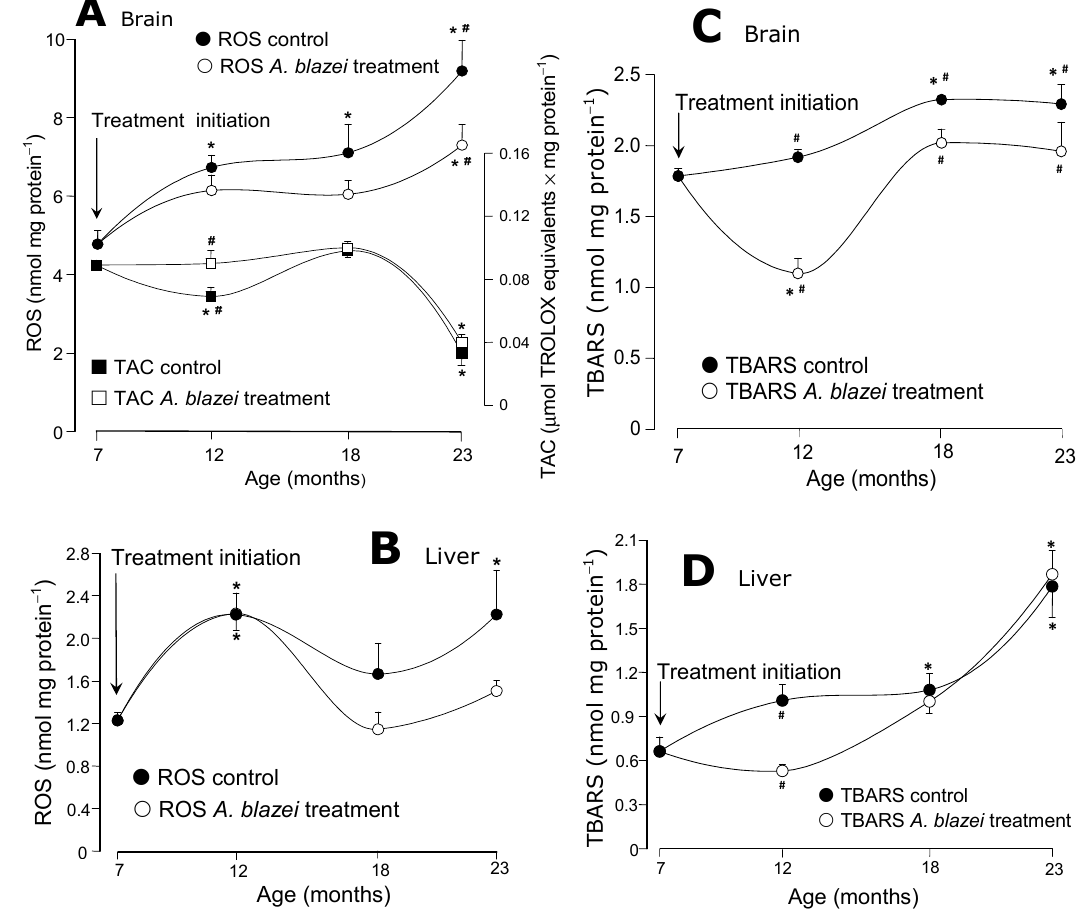
Figure 2. ( A ) Total antioxidant capacity (TAC) and oxygen reactive species (ROS) levels of the brain homogenate. ( B ) Total antioxidant capacity (TAC) and oxygen reactive species (ROS) levels of the liver homogenate. ( C ) Lipid peroxidation levels (TBARS) of the brain homogenate. ( D ) Lipid peroxidation levels (TBARS) of the liver homogenate. The data points represent the means ± mean standard errors of five to seven animals. The statistical analysis consisted of MANOVA followed by Duncan’s multiple range post hoc testing. Data points labeled with asterisks (*) are values significantly different ( p ≤ 0.05) from those found at 7 months (treatment initiation). Statistically different pairs of values for a given age are labeled with hashes